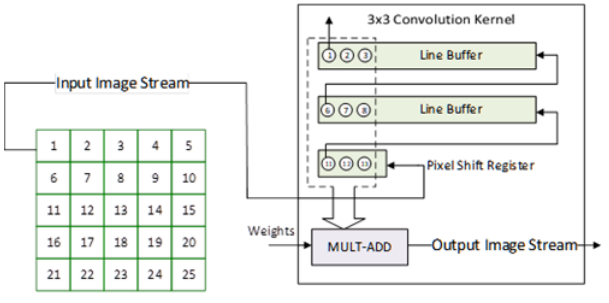
Figure 4. Image Convolution Kernel